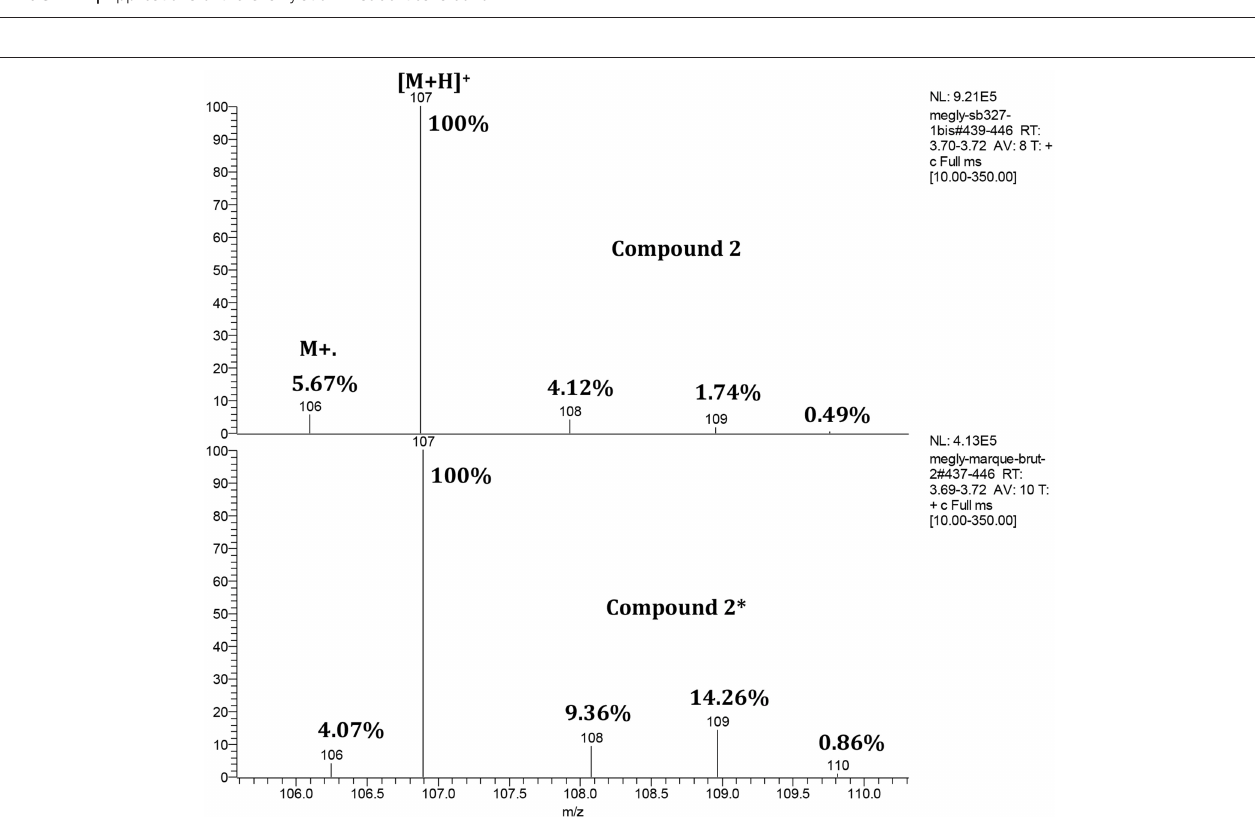
FIGURE 3 | Zoom of the isotopic cluster concerning the GC-MS analysis of compound 2 and compound